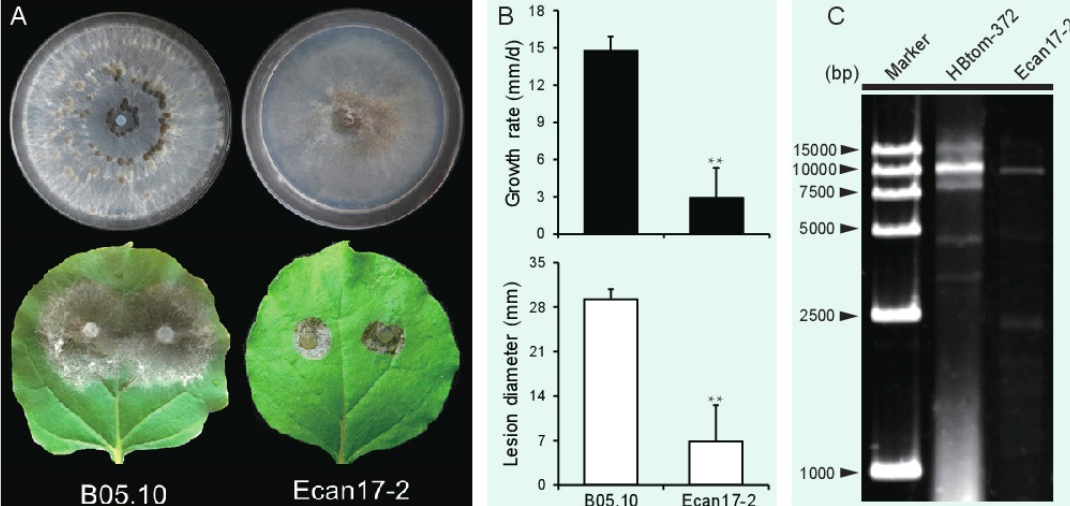
Figure 1. ( A ) Culture morphology (upper, 20 °C, 9 days) and pathogenicity assay (lower, 20 °C, 3 days) of Botrytis cinerea strains Ecan17-2 and B05.10 on potato dextrose agar (PDA) and detached N .